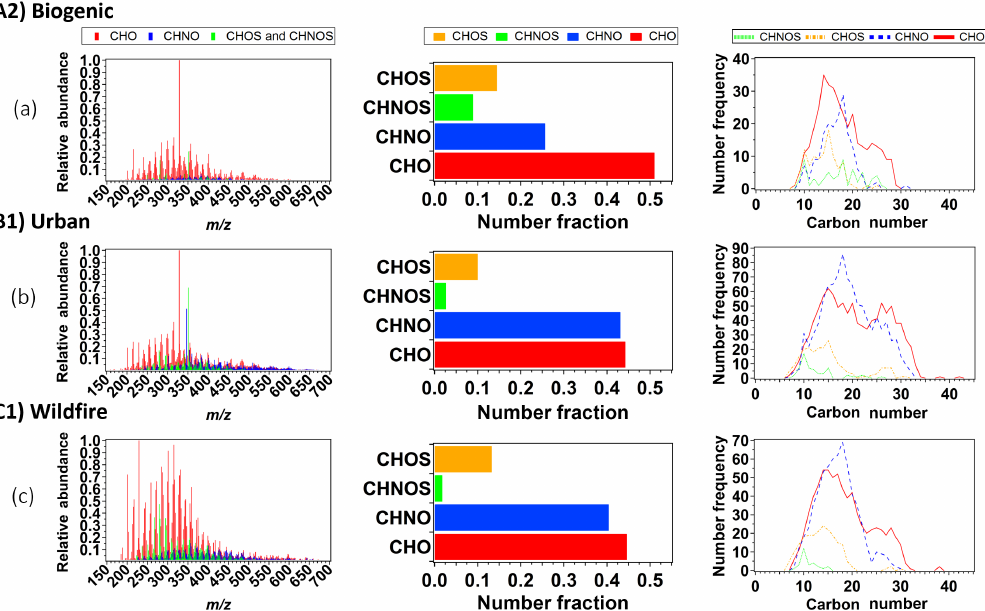
Figure 2. ( − ) ESI-FTICR mass spectra (left panels), compound-type number fractions (middle panels), and carbon number frequency distribution (right panels) of compound types (CHO, CHNO, CHOS, and CHNOS) for representative cloud water samples collected on (a) 17 August 2014 06:00–09:00EDT (A2), under northern forest (biogenic) influence combined with urban pollution, (b) 2 September 2014 06:00–09:00EDT (B1), under urban pollution influence, and (c) 4 August 2014 18:00–21:00EDT (C1), under the influence of Canadian wildfires. Mass spectra, compound-type number fractions, and carbon number distributions for the remaining samples are shown in Figs. S2 and S3,